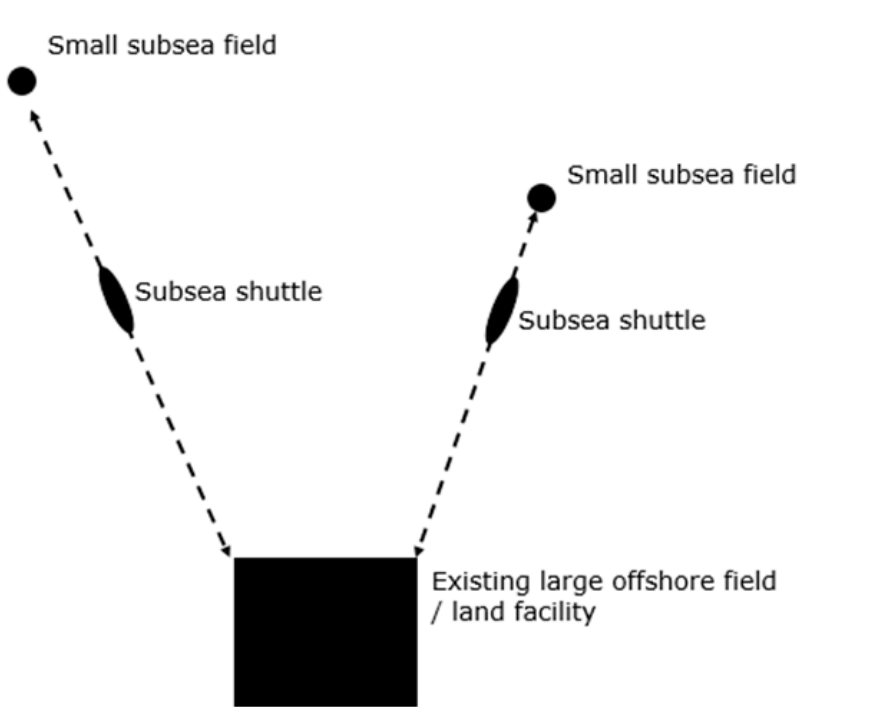
Figure 2. Subsea shuttles deployed to carry cargo between small subsea fields and an existing large offshore field or land facility [3].